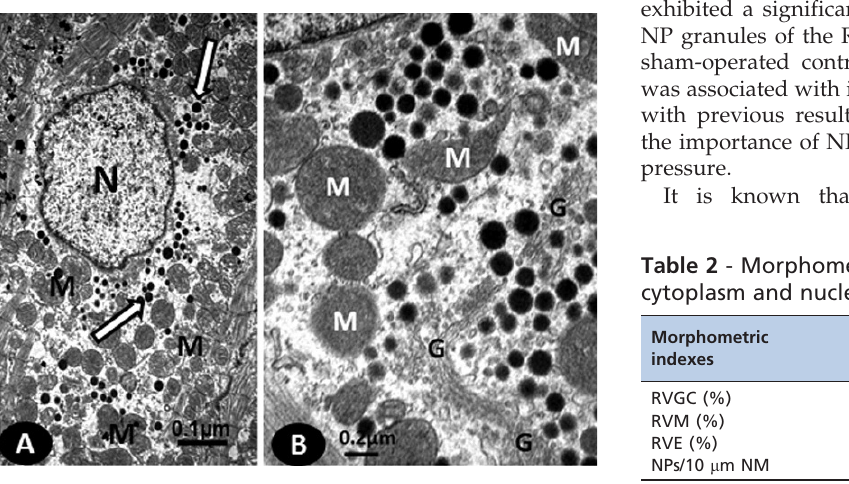
Figure 1 - Electronic photomicrographs of sections obtained from RA cardiomyocytes showing (A) the number of NP granules (white arrows) dispersed among mitochondria (M) and (B) the mitochondria with varied forms (M) and NP granules near the Golgi complex (G).